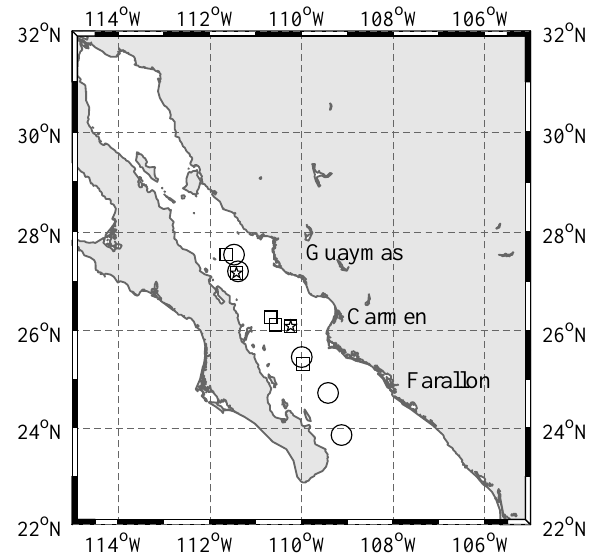
Figure 1. Location of stations in the Gulf of California where underwater radiometric and ancillary measurements were made. Circles indicate the station sites in 2010 and squares in 2011. Optical measurements were made at four, three, and four stations in the Guaymas, Carmen, and Farallon Basins, respectively. Stars indicate two stations where the absorption and beam attenuation measurements with an ac-9 instrument were made in